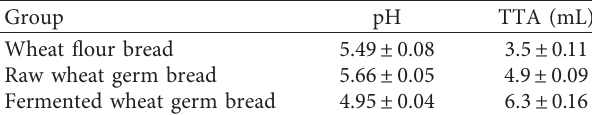
Table 4: The volatile flavor components in different groups of bread. No.